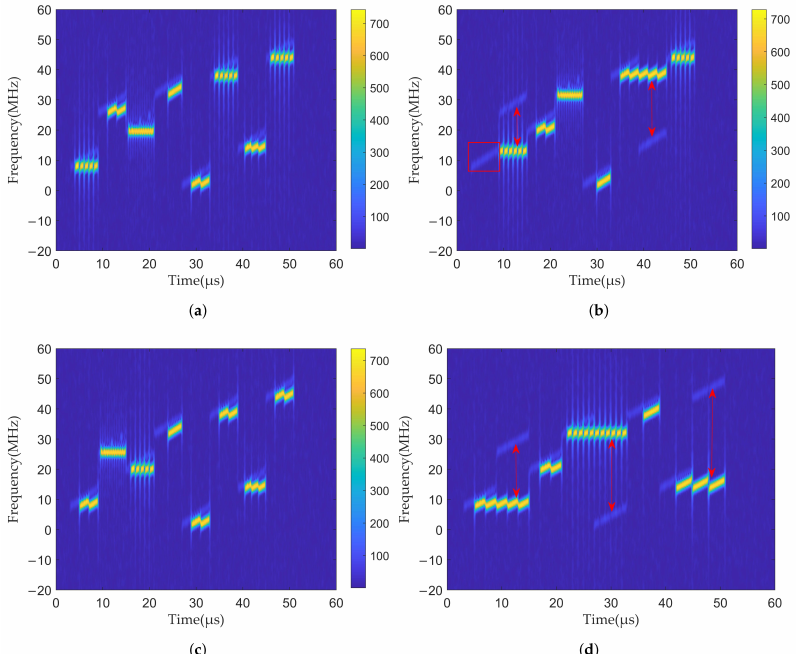
Figure 12. NUISRJ time–frequency distribution under different parameters: ( a ) parameter 1, ( b ) parameter 2, ( c ) parameter 3, ( d ) parameter 4.